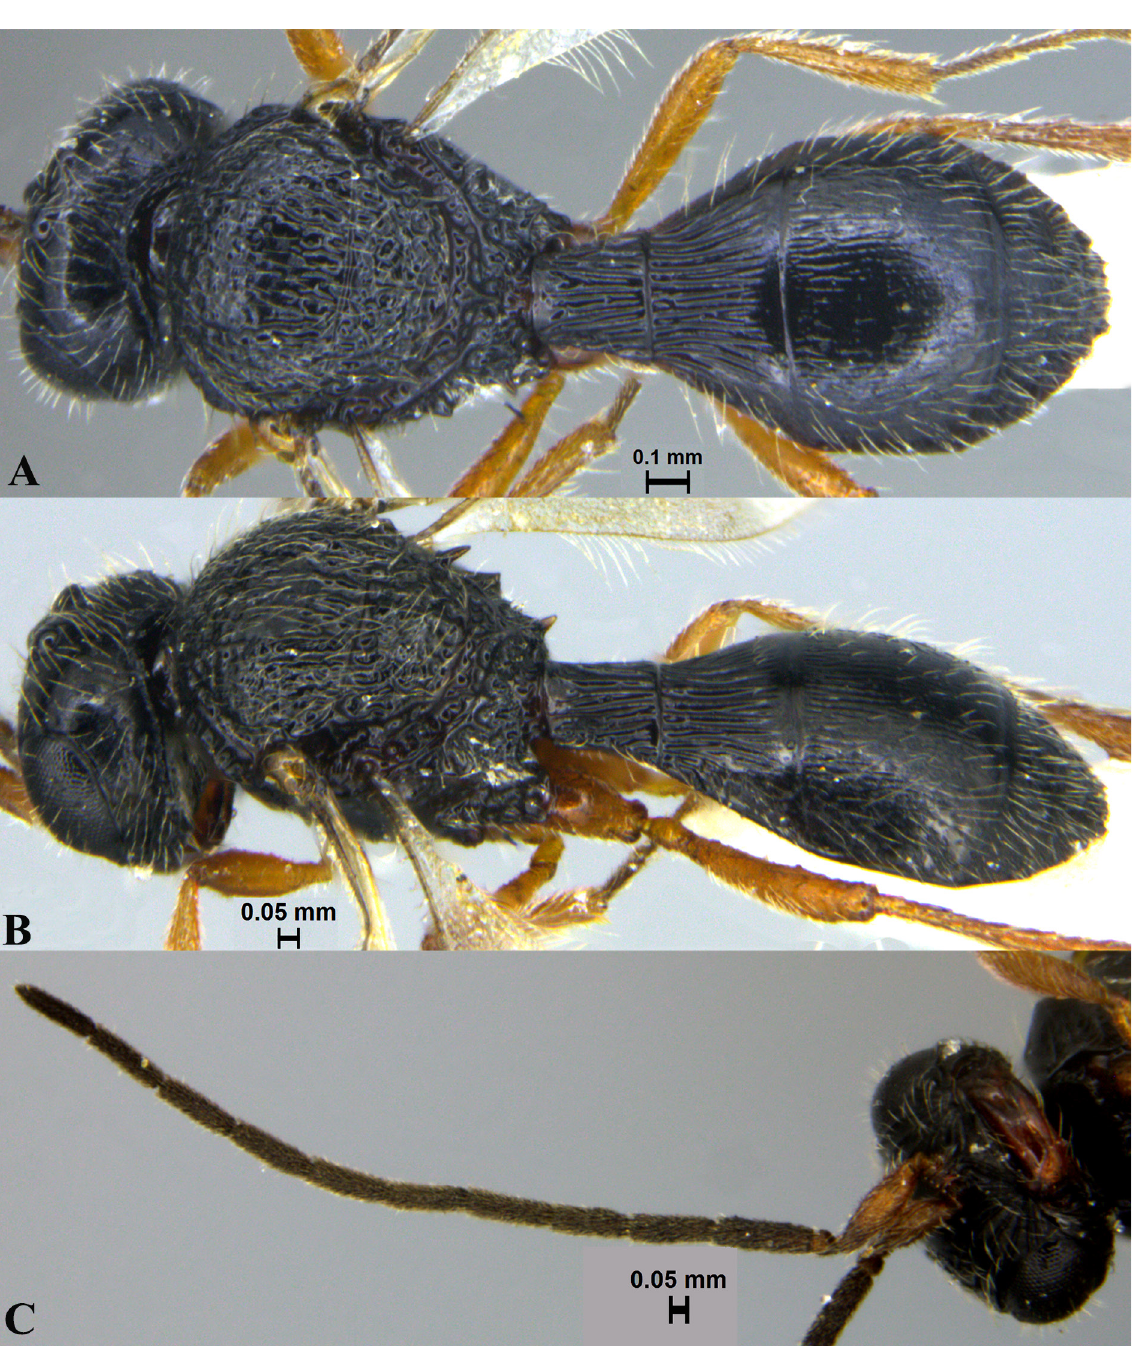
Fig. 21. Odontoscelio sp. 1. ♂ (ICAR-NBAIR P3975). A . Habitus, dorsal view. B . Habitus, showing axillular spines. C .